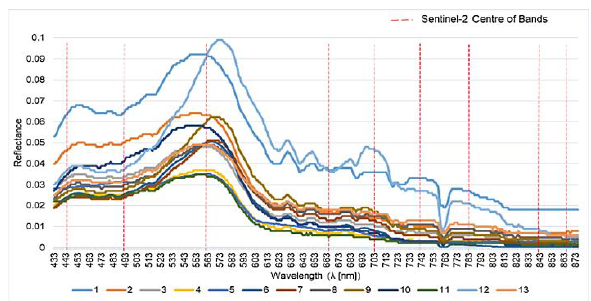
Figure 4. Spectra of 13 in situ points measured with handheld ASD FieldSpec 4 and location of Sentinel 2 spectral